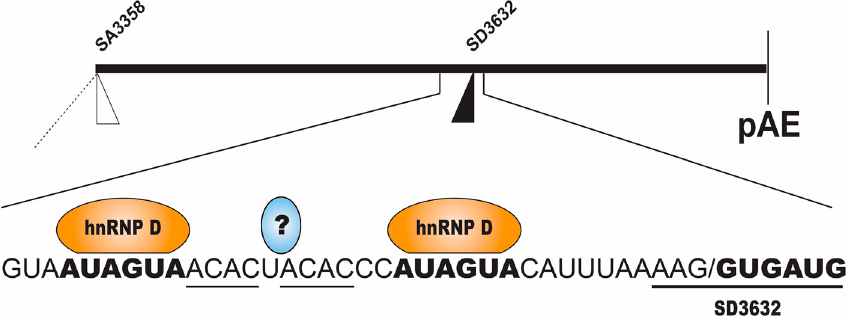
Figure 5. Schematic drawing of the middle region of the HPV16 genome with the HPV16 3 ′ -splice site SA3358 used by both early and late mRNAs, the exclusively late 5 ′ -splice site SD3632 and the early polyadenylation signal pAE. The blow up shows the suppressed HPV16 late 5 ′ -splice site SD3632 with upstream splicing silencer elements [34] consisting of two AUAGUA-motifs that bind heterogenous nuclear ribonuclear protein D (hnRNP D) and two ACAC-motifs that interact with a yet unknown cellular factor [6,9,41]. Question mark indicates unidentified cellular proteins that bind to the splicing enhancer. Binding sited for hnRNP D and the intronic region of HPV16 late 5 ′ -splice site SD3632 are in boldface, and entire SD3632 is underlined.